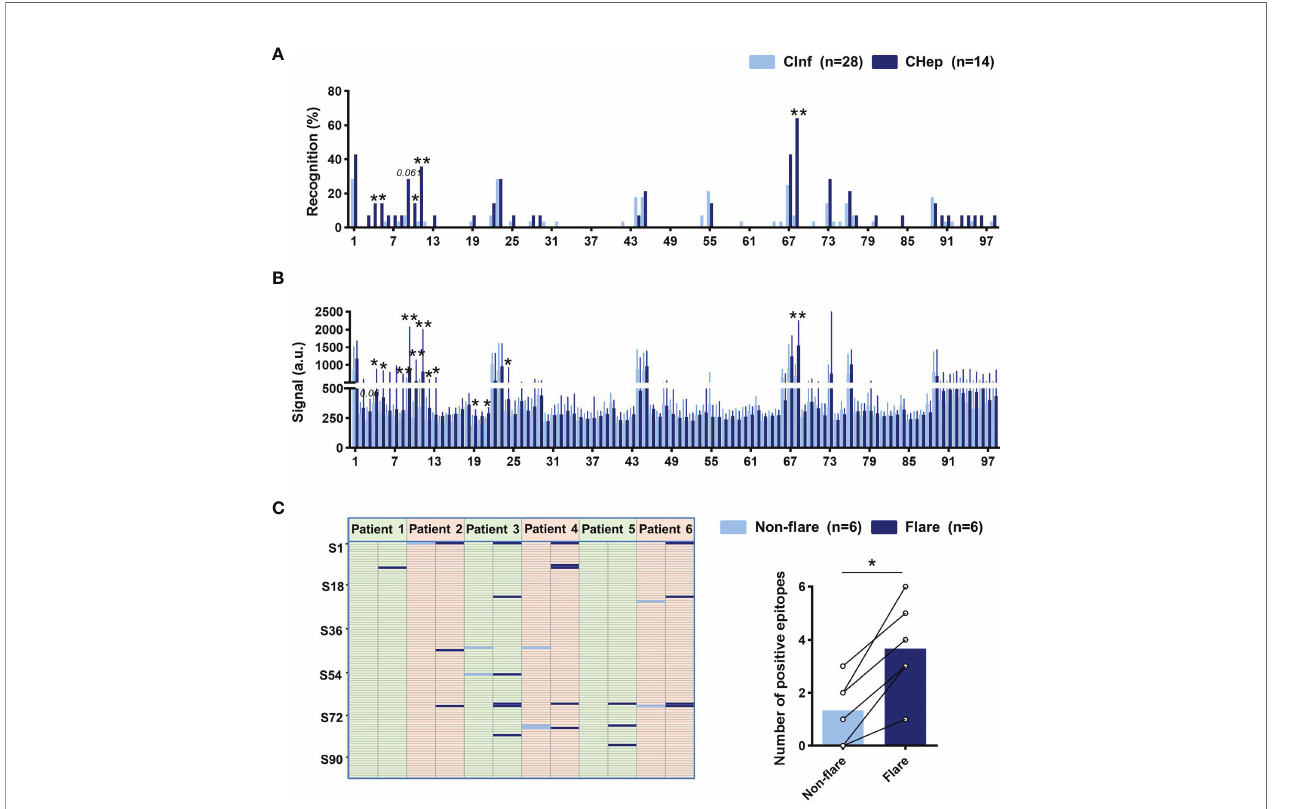
FIGURE 5 | Linear B-cell epitope variation between chronic HBV infection (CInf) and chronic hepatitis B (CHep). (A) Comparison of the recognition rate of each peptide between CInf and CHep patients. (B) The original signal change of each peptide between CInf and CHep patients. (C) Distribution of linear B-cell epitopes of six patients who transitioned from the non fl are eAg + CInf phase to the eAg + CHep phase with ALT fl ares. Positive epitopes were plotted in the non fl are (light blue bar) and fl are (dark blue bar) phases (left). Comparing the number of positive peptides between ALT non fl are and fl are phases (right). (A) Chi-square test. (B) Mann – Whitney U test. (C) Wilcoxon signed-rank test. * P < 0.05, ** P <